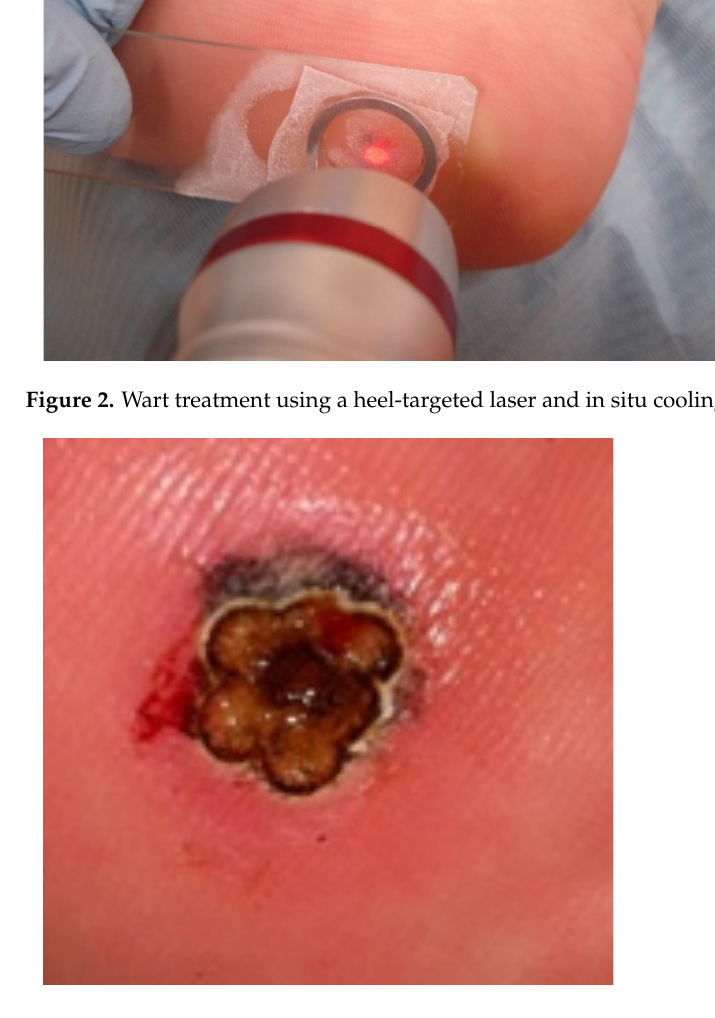
Figure 2. Wart treatment using a heel-targeted laser and in situ cooling.